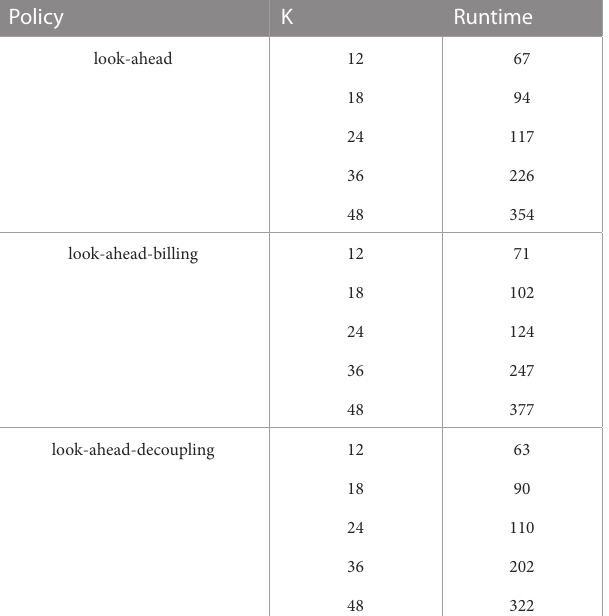
TABLE5 Runtime(inseconds)ofthethreepoliciestestedinthefirstREC. Policy K Runtime